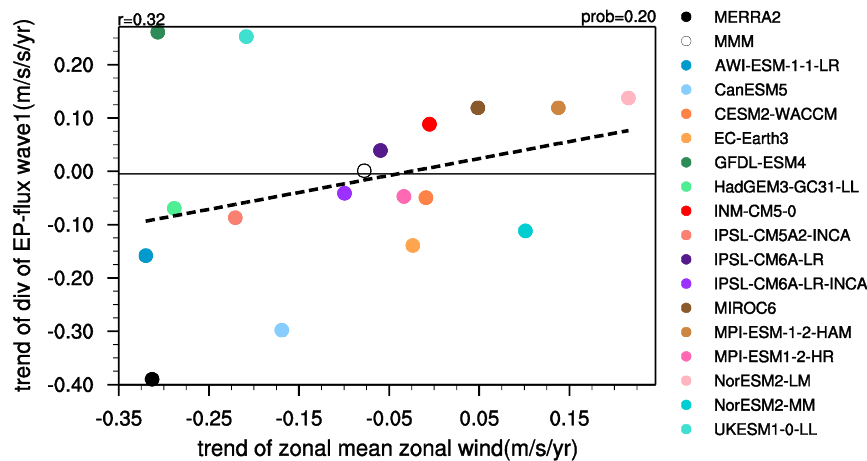
Figure 7. Correlation between the trend of EP-flux divergence in zonal wavenumber-1 accumulated in early winter from 10 December to 10 January at 1 – 10 hPa averaged over 45° – 75°N and the trend in zonal mean zonal winds averaged at 1 – 100 hPa over 60° – 90°N in the late winter from 10 January to 28 February for the period 1980/81 – 2013/14. All calculations are based on daily mean derived from MERRA2 and simulations of 16 CMIP6 models. Each symbol represents an individual CMIP6 model, while the black dot denotes MERRA2.